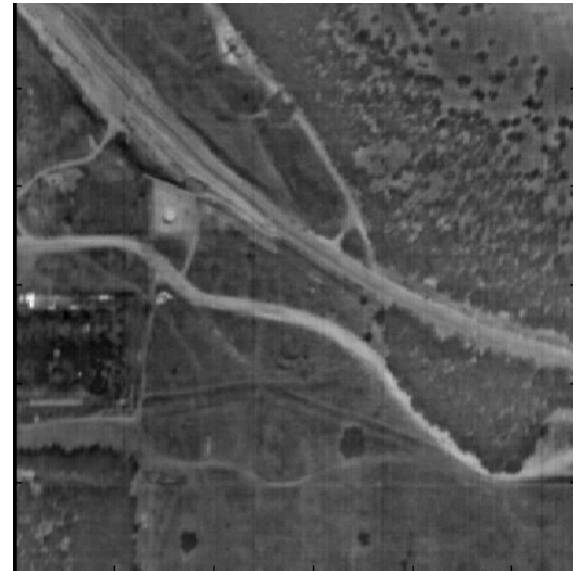
Figure 6. The dataset “field” is an hyperspectral image of a field taken by an airplane flying 9,500 feet above sea level. The resolution is 1.2 m/pixel, 286 × 300 pixels per waveband with 50